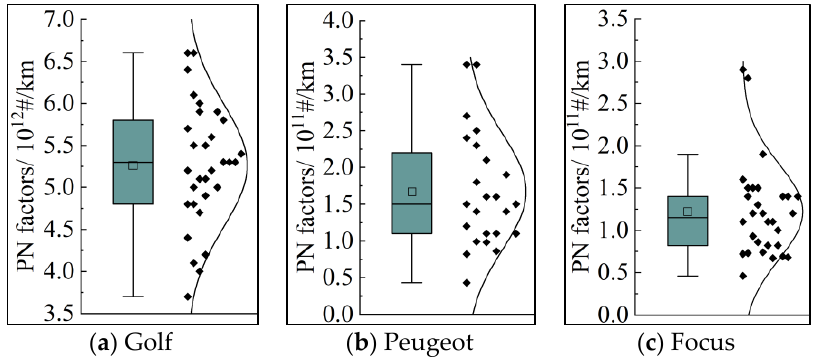
Figure 14. Average PN emission.